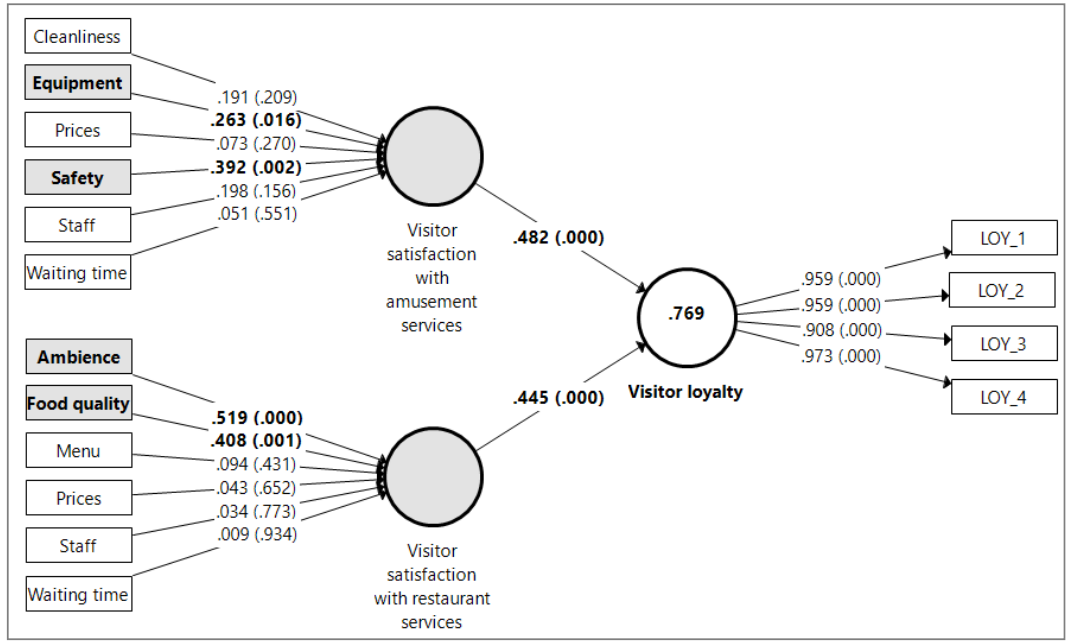
Figure 3. Structural model relationships assessment. Note: Results obtained after running the PLS-SEM bootstrapping procedure with 5000 subsamples . Values on arrows = outer weights (for visitor satisfaction), outer loadings (for the visitor loyalty), path coefficients (between constructs), p values (in parentheses). Value in circle = R 2 . Bold values = statistically significant.